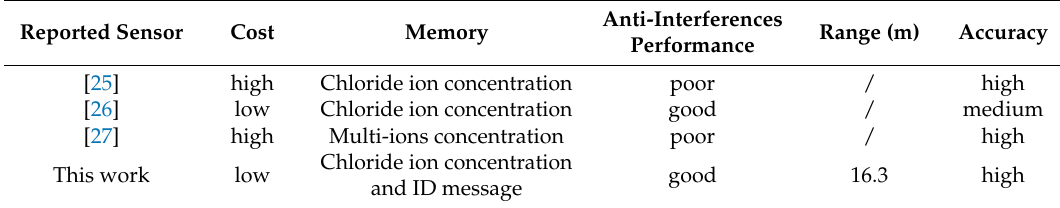
Table 5. Performances comparison of wireless chloride ion